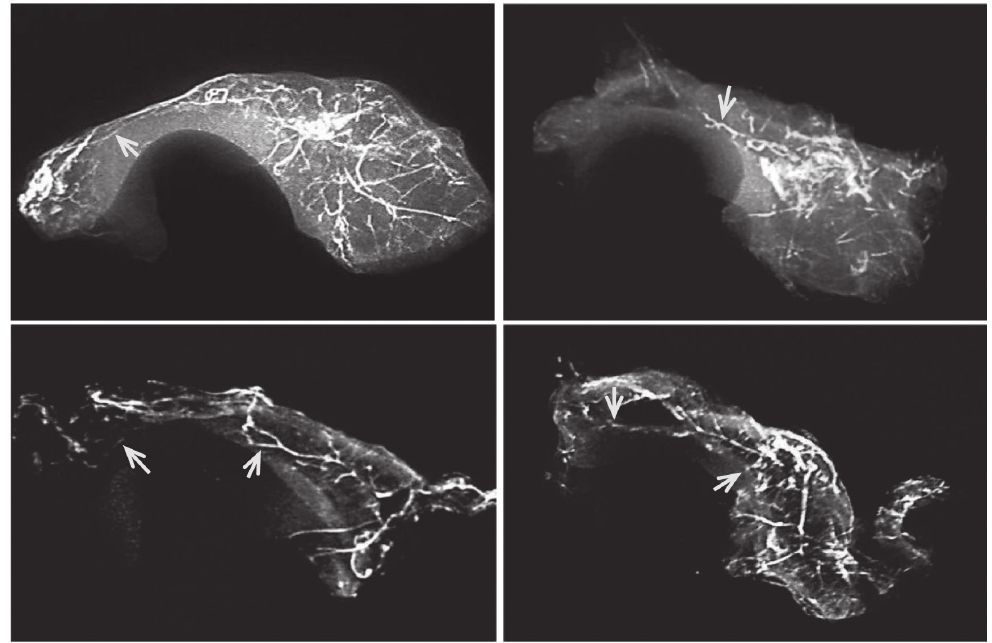
Figure 6 - Contrasted radiographs of treated menisci (TM), showing vascularization of the perimeniscus tissue and peripheral edge of the meniscal body and horns (arrows). (See the colors in the online